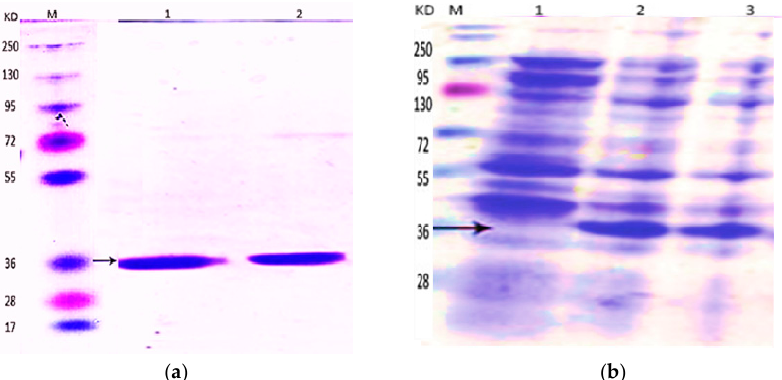
Figure 1. ( a ) Expression of BCN-E 50-52 in E. coli BL21 . M: size marker; lane 1: total protein before induction; lane 2: total protein 2 h after induction; lane 3: total protein 24 h after induction. ( b ) Purification and refolding of BCN-E 50-52. M: size marker; lane 1: fusion protein retrieved by nickel affinity chromatography; lane 2: protein after refolding.